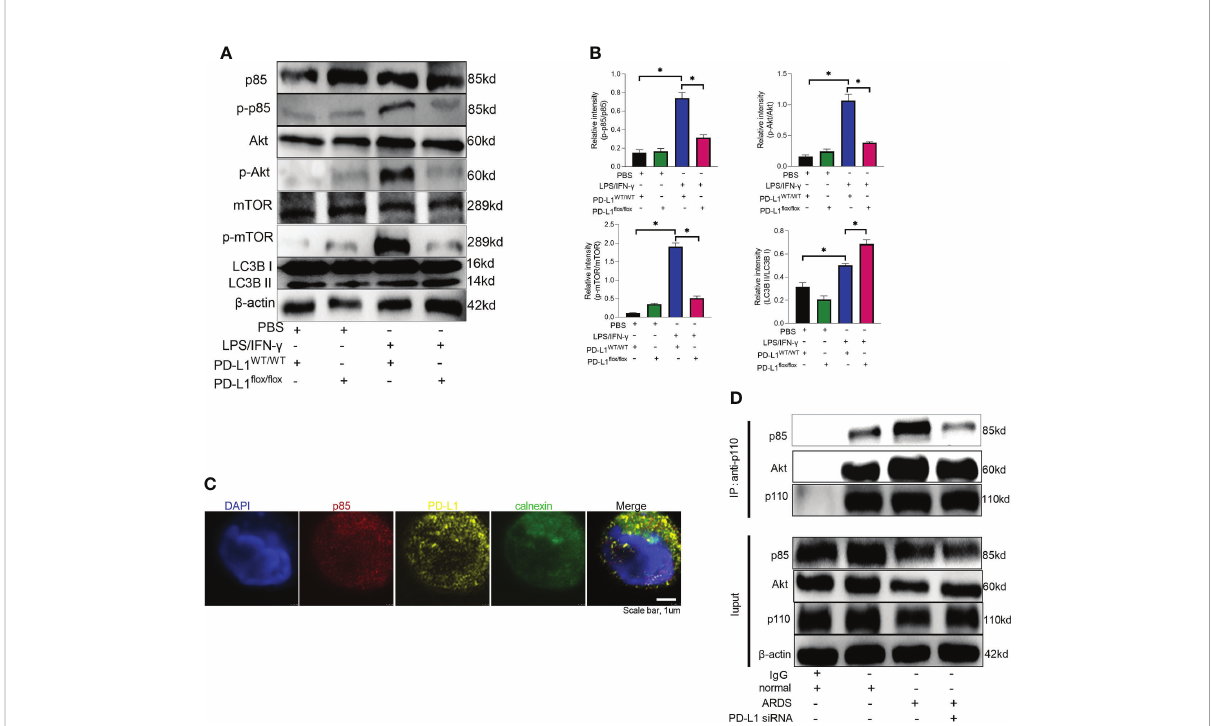
FIGURE 5 PD-L1 binds to p85 on the ER to regulate autophagy via PI3K/Akt/mTOR pathway. (A) Neutrophils from PD-L1WT/WT mice or PD-L1 fl ox/ fl ox mice are stimulated with IFN- g (10ng/ml) and LPS (1 m g/ml) for 21 hours. Protein levels of p85, p-p85, Akt, p-Akt, mTOR, p-mTOR and LC3B II/I in neutrophils were evaluated by western blot analysis. (B) Integrated optical density ratio of p-p85/p85, p-Akt/Akt, P-mTOR/mTOR, and LC3B II/LC3B (I) The values presented are mean ± SEM (n=3; *P<0.05, one-way analysis of variance). (C) PD-L1 and p85 overlap on the ER in neutrophils from ARDS patients, which was con fi rmed by confocal microscopy (blue: DNA; red: p85; yellow: PD-L1; green: calnexin (ER marker)) (scale bar: 1um). (D) Neutrophils were transfected with PD-L1 siRNA. Immunoprecipitating p110 demonstrates that p110 complexes with more p85 and Akt in ARDS patients. The values presented are mean ± SEM (n=3; *P<0.05, one-way analysis of